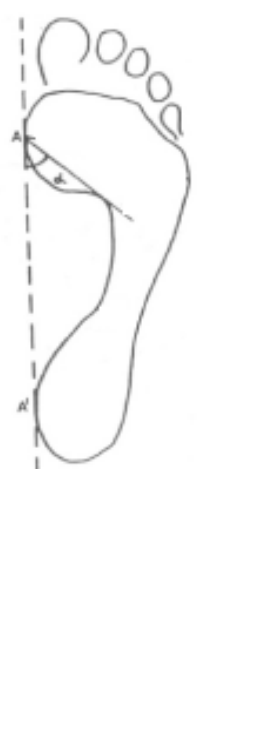
Figure A. Parameters to calculate Clarke angle